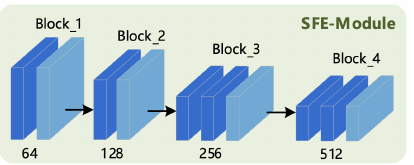
Figure 2. Three-Dimensional Shallow Feature Extraction (SFE) Module.